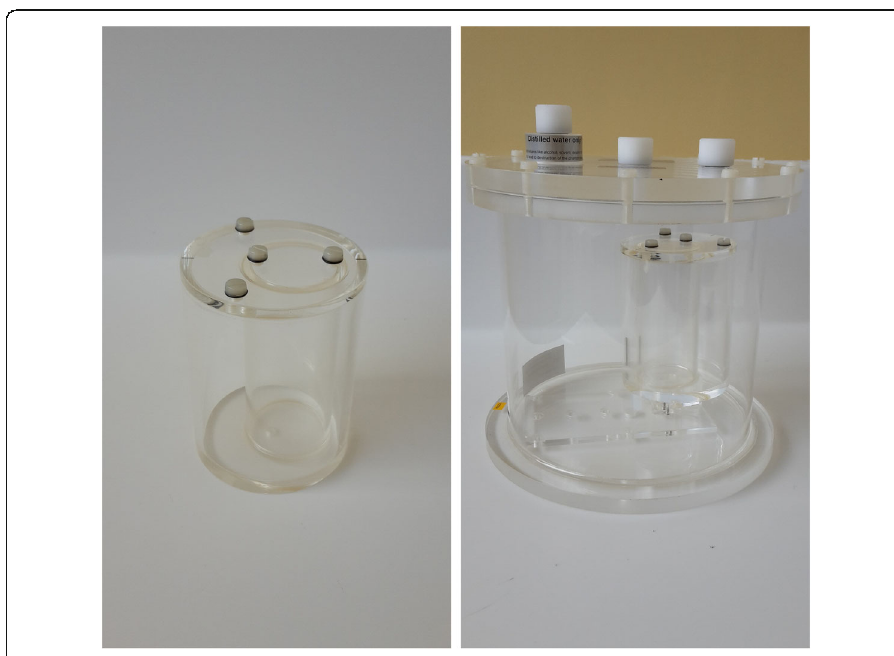
Fig. 2 Heart phantom insert (left), and an example of a verification phantom setup with the heart insert placed in a head phantom